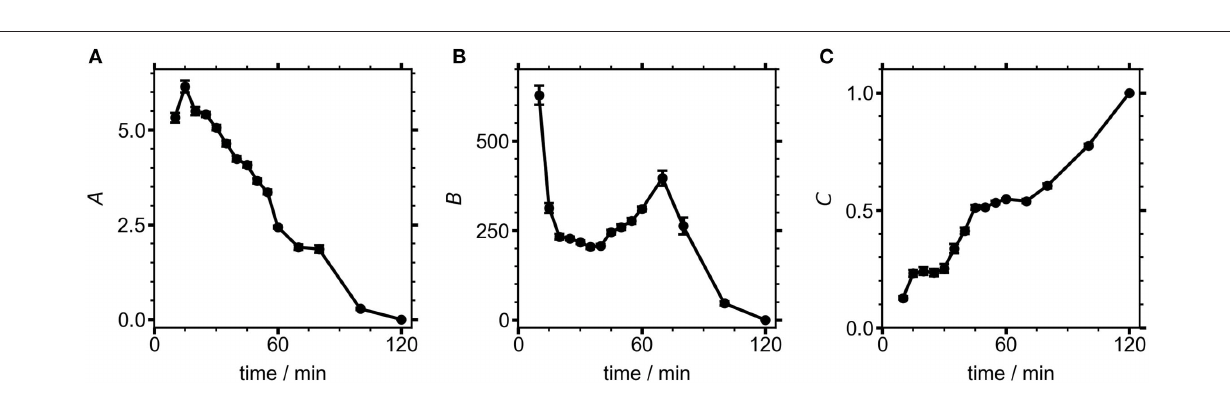
Frontiers in Chemistry |